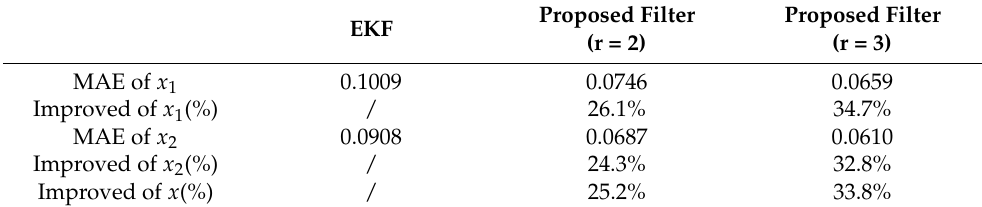
Figure 4. Estimation error of state 2. Table 1. Error comparison between the proposed filter and EKF in case